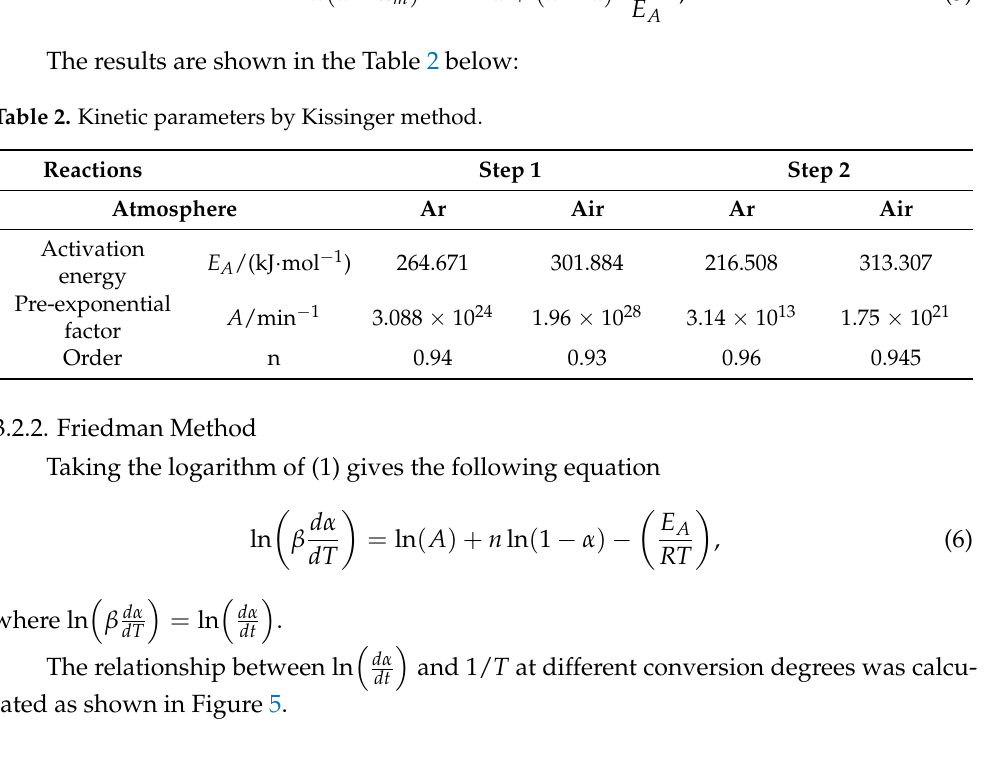
×10 3 1/T m ( ) (cid:0) (cid:1) − 2 ln / T by Kissinger method under inert and air atmosphere. T β − 1/ β / T 2 m 1/ T m by Kissinger method under inert and air atmosphere. m m